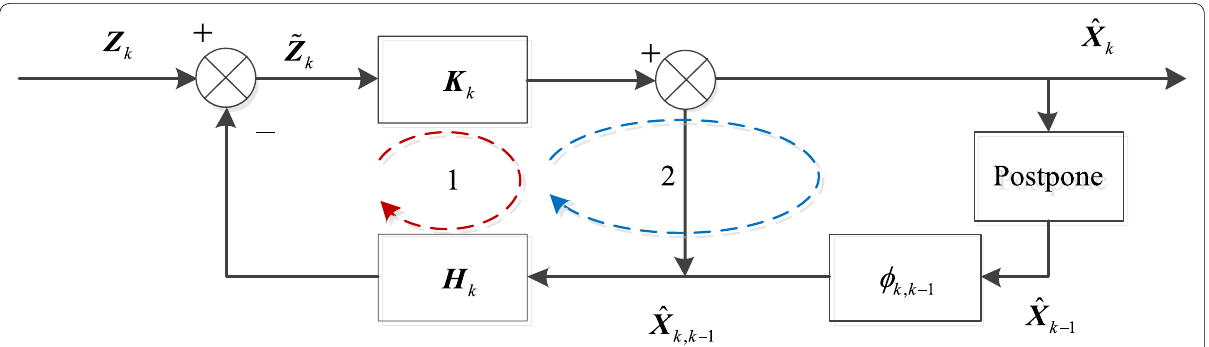
Fig. 1 The filtering process of the linear Kalman filter